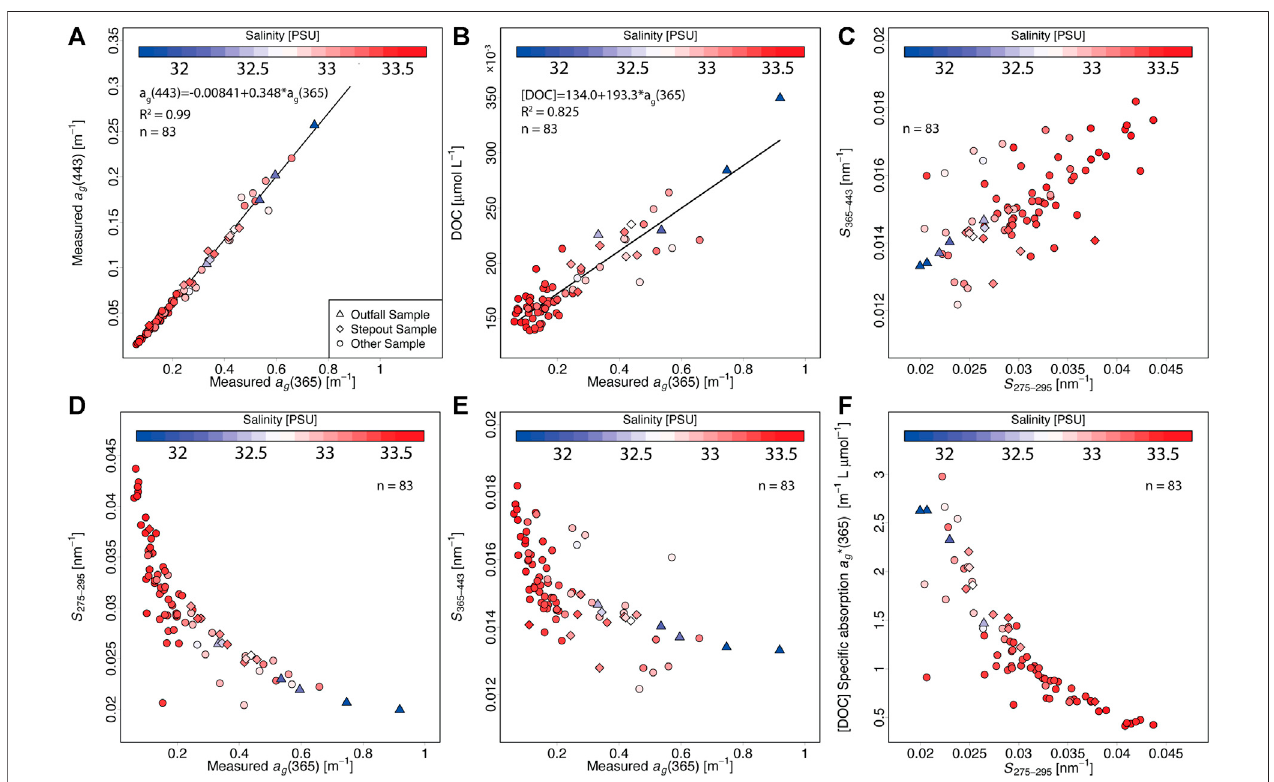
FIGURE 4 | Plots of CDOM absorption characteristics: (A) relationship between absorption coef fi cients of CDOM at 365 and 443 nm, (B) relationship between a g (365) and [DOC], (C) spectral slope in the UV-B ( S 275 – 295 ) versus UV-A to visible ( S 365 – 443 ) domain, (D) relationship between a g (365) and S 275 – 295 , (E) relationship between a g (365) and S 365 – 443 , and (F) relationship between S 275 – 295 and [DOC]-speci fi c absorption by CDOM ( a p g ). Organic matter in ef fl uent impacted samples, collected at the 1-mile outfall during the diversion, occurs in relatively high abundance, but does not differ in absorption characteristics from other CDOM sources.